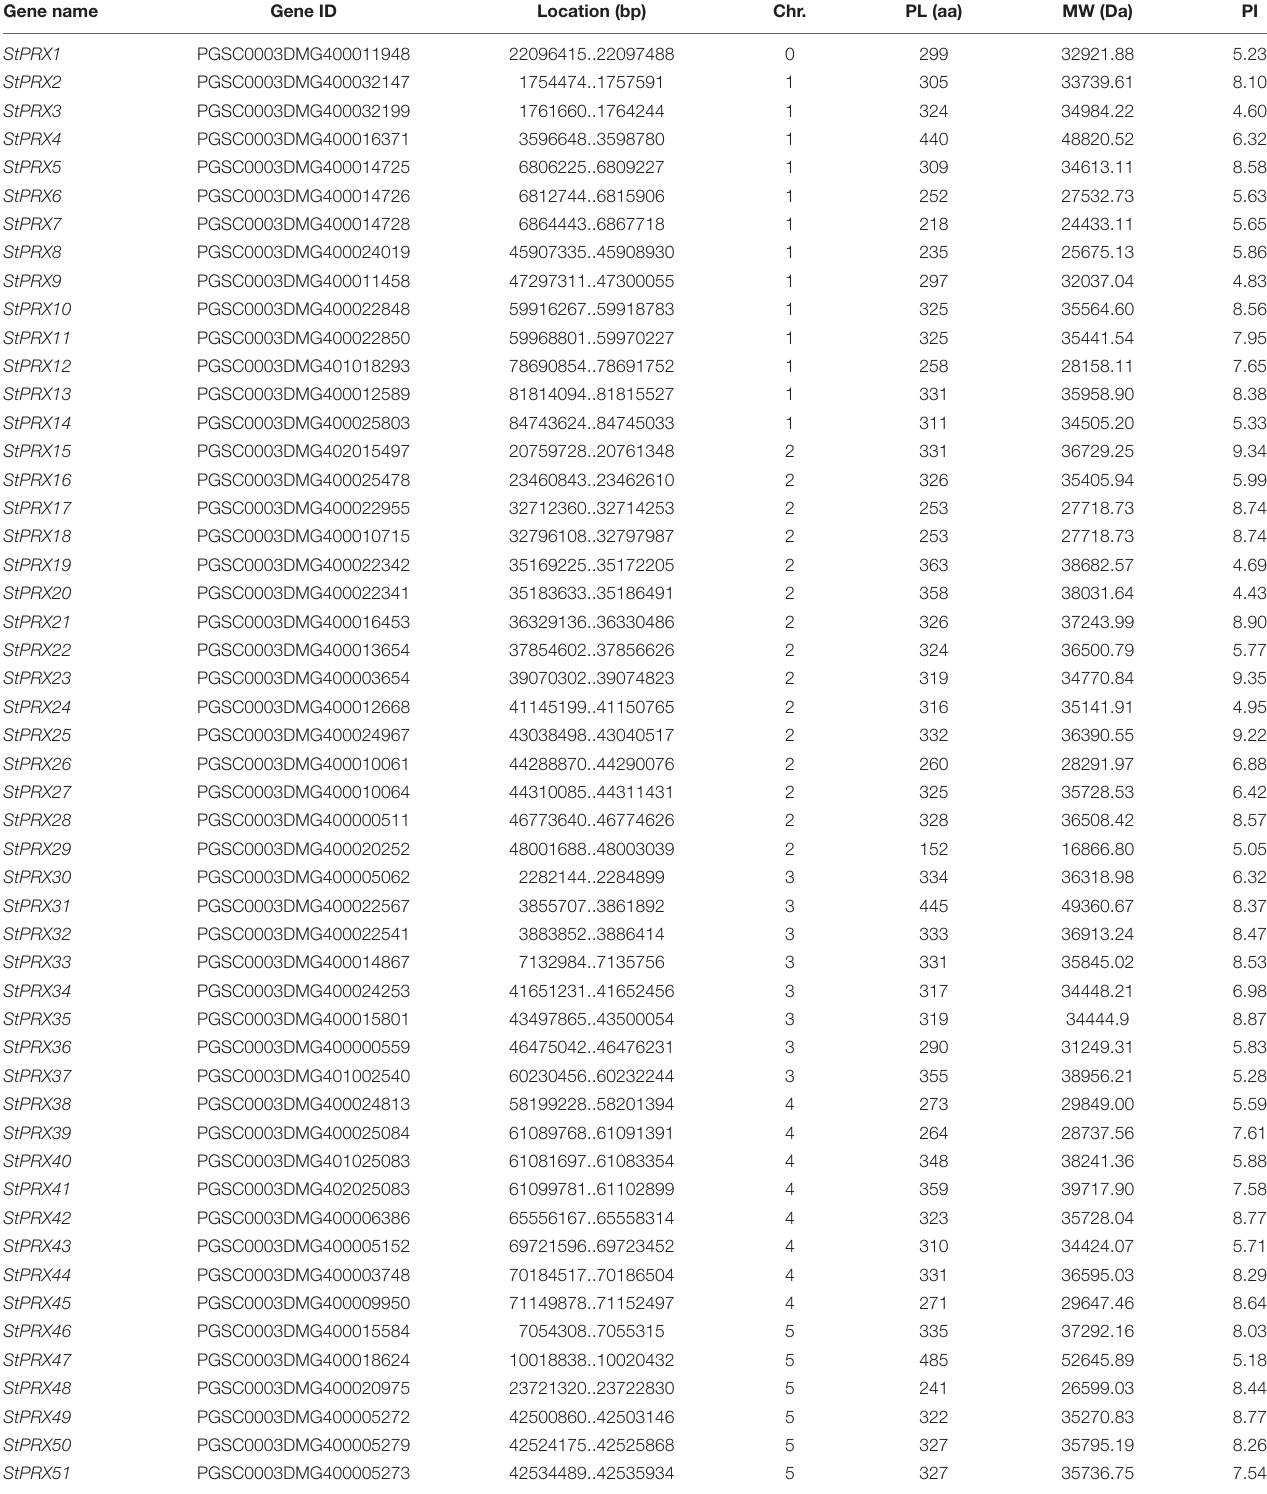
TABLE 1 | The characters of 102 PRX gene family members in Solanum